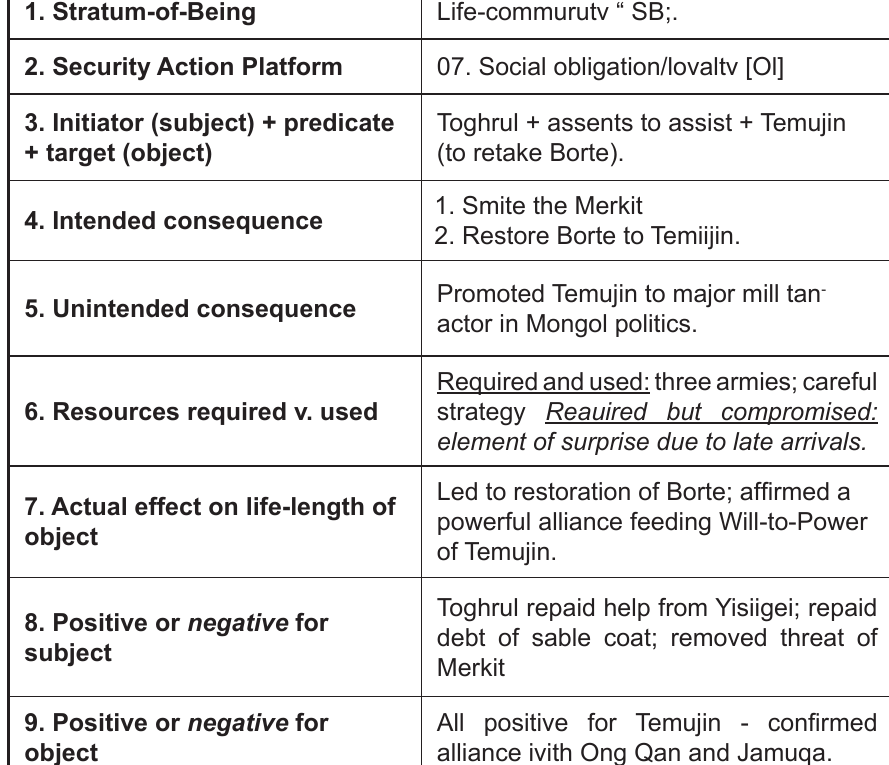
Figure 9: Toghrul helps Temujin to rescue Borte from the Merkit Third illustrative incident: Formation of bodyguard